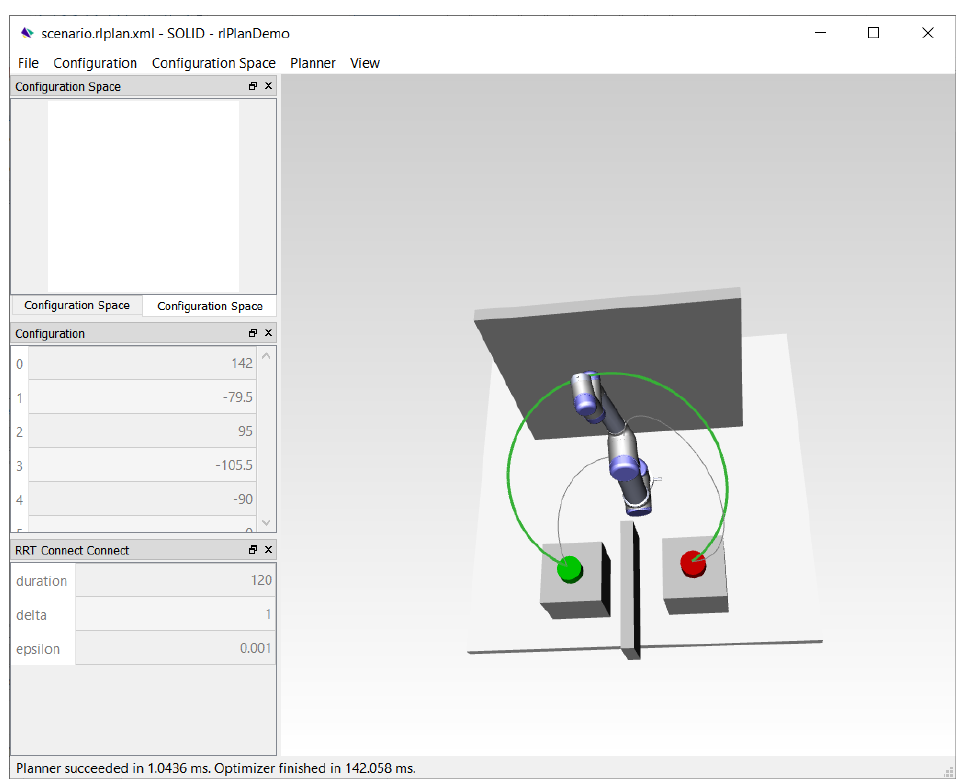
Figure 16. Screen capture of a Robotics Library [58] simulation with a UR 5 six degrees of freedom (6-DOF) robot following a path generated by the RRT Connect algorithm [57]. Table 2. Comparative performances of the proposed method with respect to those of four other motion planning algorithms [26,27,31,57]. SAC: Soft Actor-Critic, DOF; degrees of freedom, ASA: adaptive simplex architecture, and MPC: model predictive